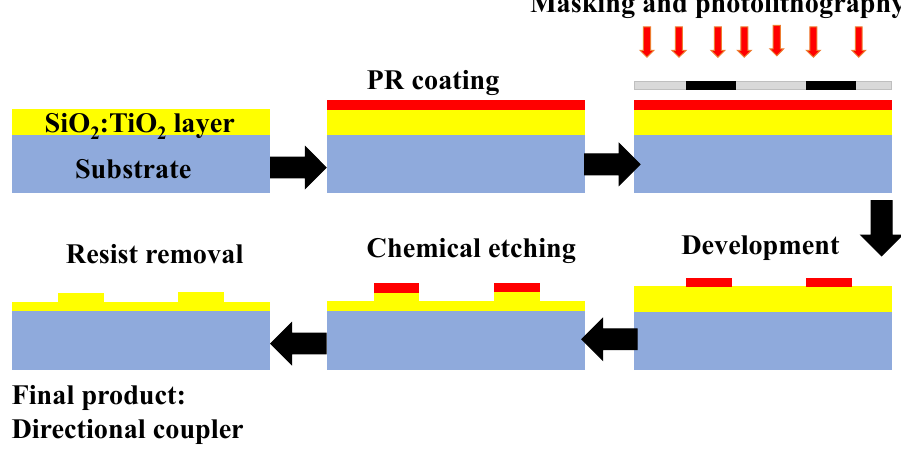
Figure 10. Fabrication steps of DC as mentioned in [184].